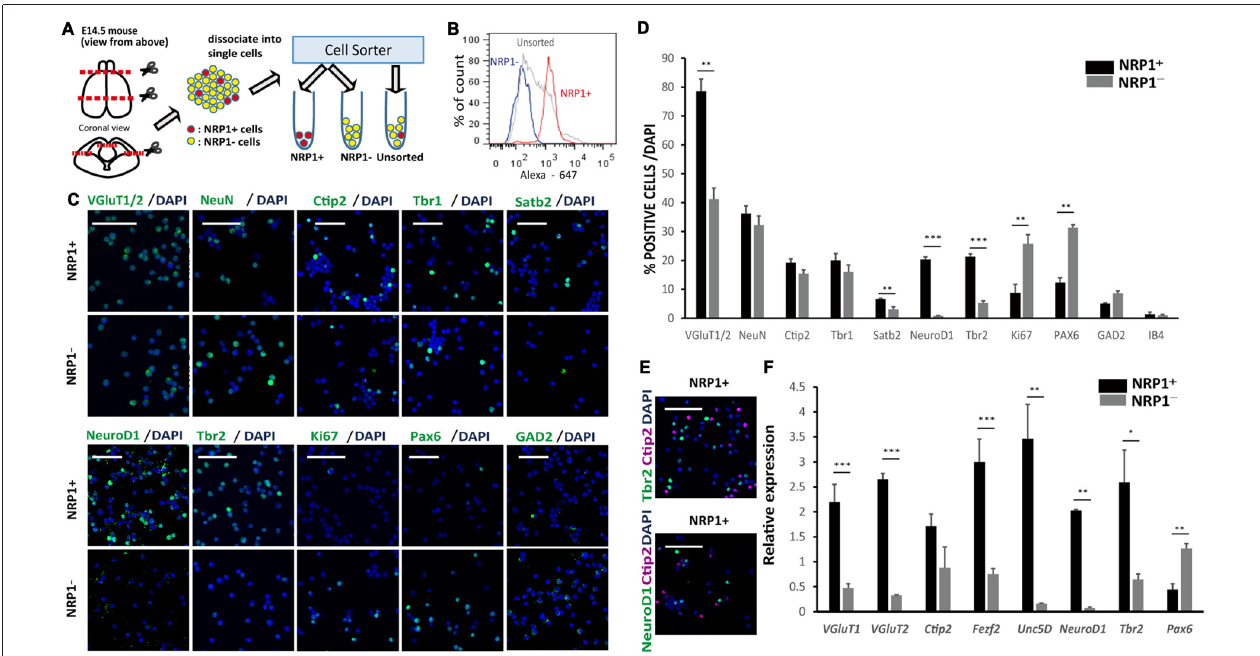
FIGURE 2 | Characterization of murine cerebral cortex-derived NRP1 + cells immediately after cell sorting. (A) The cell sorting procedure. Rostral 2/3 of E14.5 cerebral cortex is harvested, dissociated by Accumax (cid:114) into single cells, and divided into three groups (NRP1 + , NRP1 − and Unsorted). (B) A histogram of the fluorescence-activated cell sorting (FACS) analysis of NRP1 + , NRP1 − and unsorted cells. (C) Immunostaining of NRP1 + and NRP1 − cells for VGluT1/2, NeuN, Ctip2, Tbr1, Satb2, NeuroD1, Tbr2, Ki67, Pax6 and GAD2 (green)/DAPI (blue). Scale bars, 50 µ m. (D) Frequency distribution of several neural markers as a percentage of total DAPI stained cells in each group. (E) Immunostaining of NRP1 + cells for Tbr2 (green)/Ctip2 (magenta)/DAPI (blue) and NeuroD1 (green)/Ctip2 (magenta)/DAPI (blue). Scale bars, 50 µ m. (F) Quantitative real time polymerase chain reaction (RT-PCR). The expression level of unsorted cells was set to 1. Values are the mean ± SEM. ∗ p < 0.05, ∗∗ p < 0.01 and ∗∗∗ p < 0.001 by one way analysis of variance (ANOVA; n = 3 independent